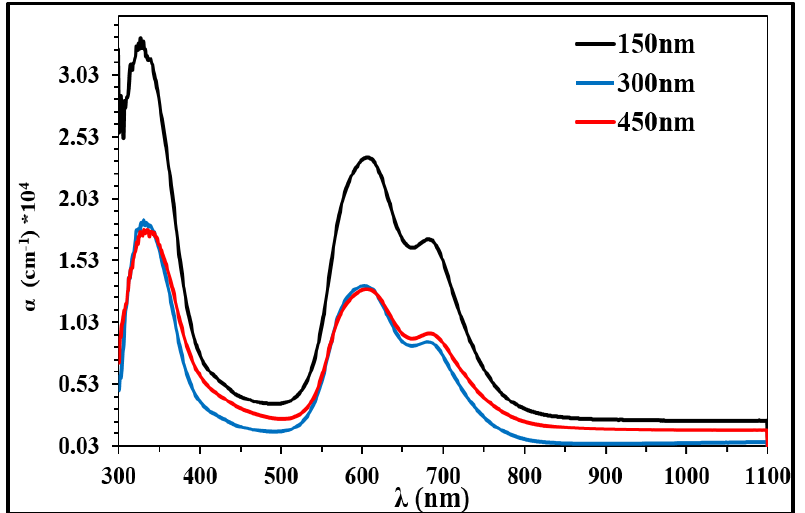
Fig.5: The coefficient of the absorption as function of wavelength for thin film of CuPc considering a variety of the thickness